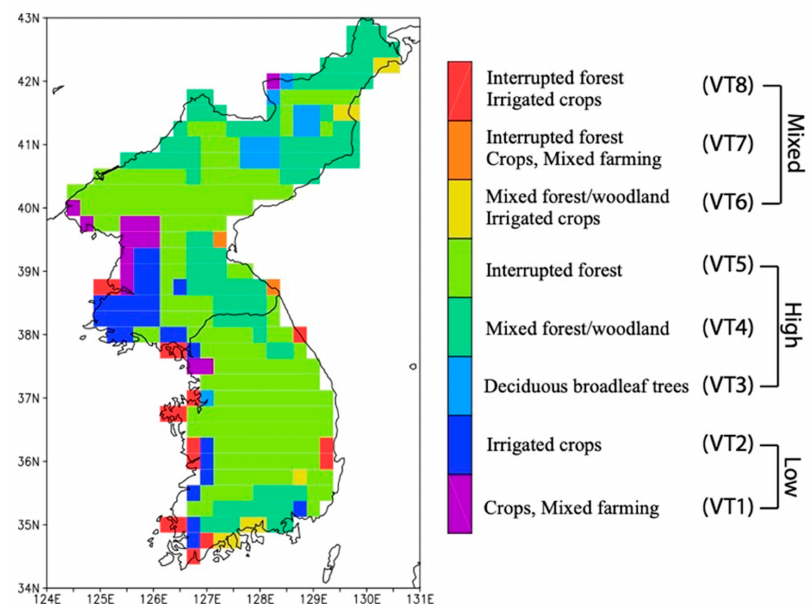
Figure 3. Vegetation reclassification in the Korean Peninsula according to vegetation type and Figure 5